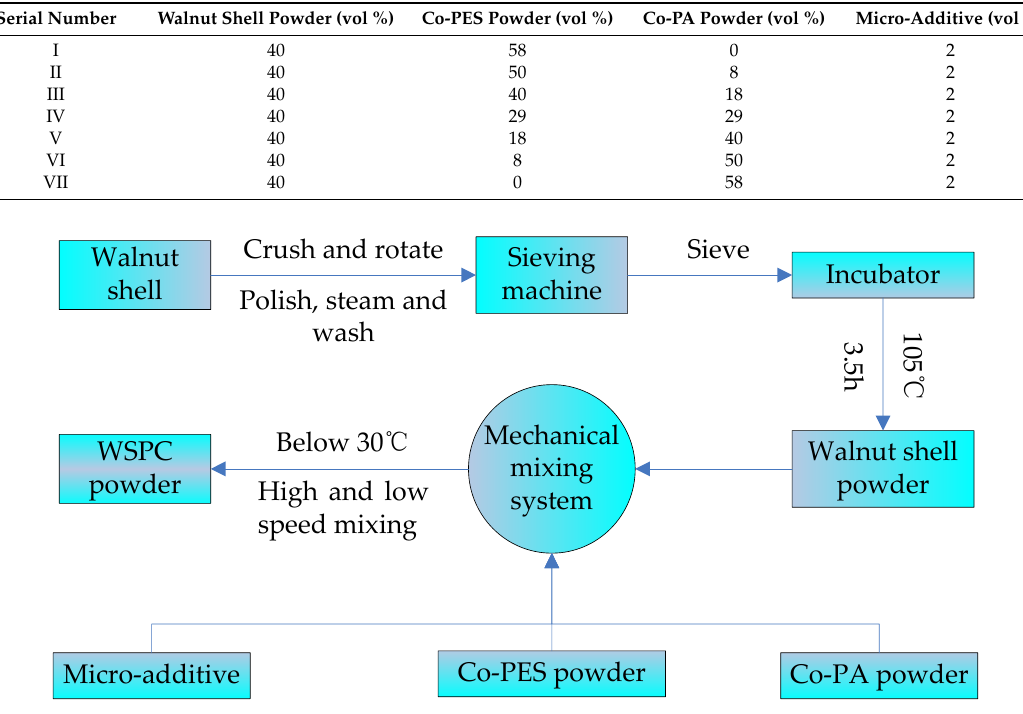
Table 1. Quantities of the ingredients in the walnut shell composites (WSPC) powder.